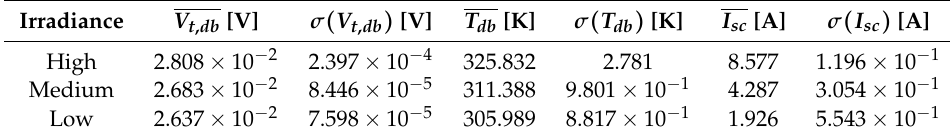
Table 11. Thermal voltage and temperature for bypass diode in submodule 3 and short-circuit current for high, medium and low irradiances from experimental